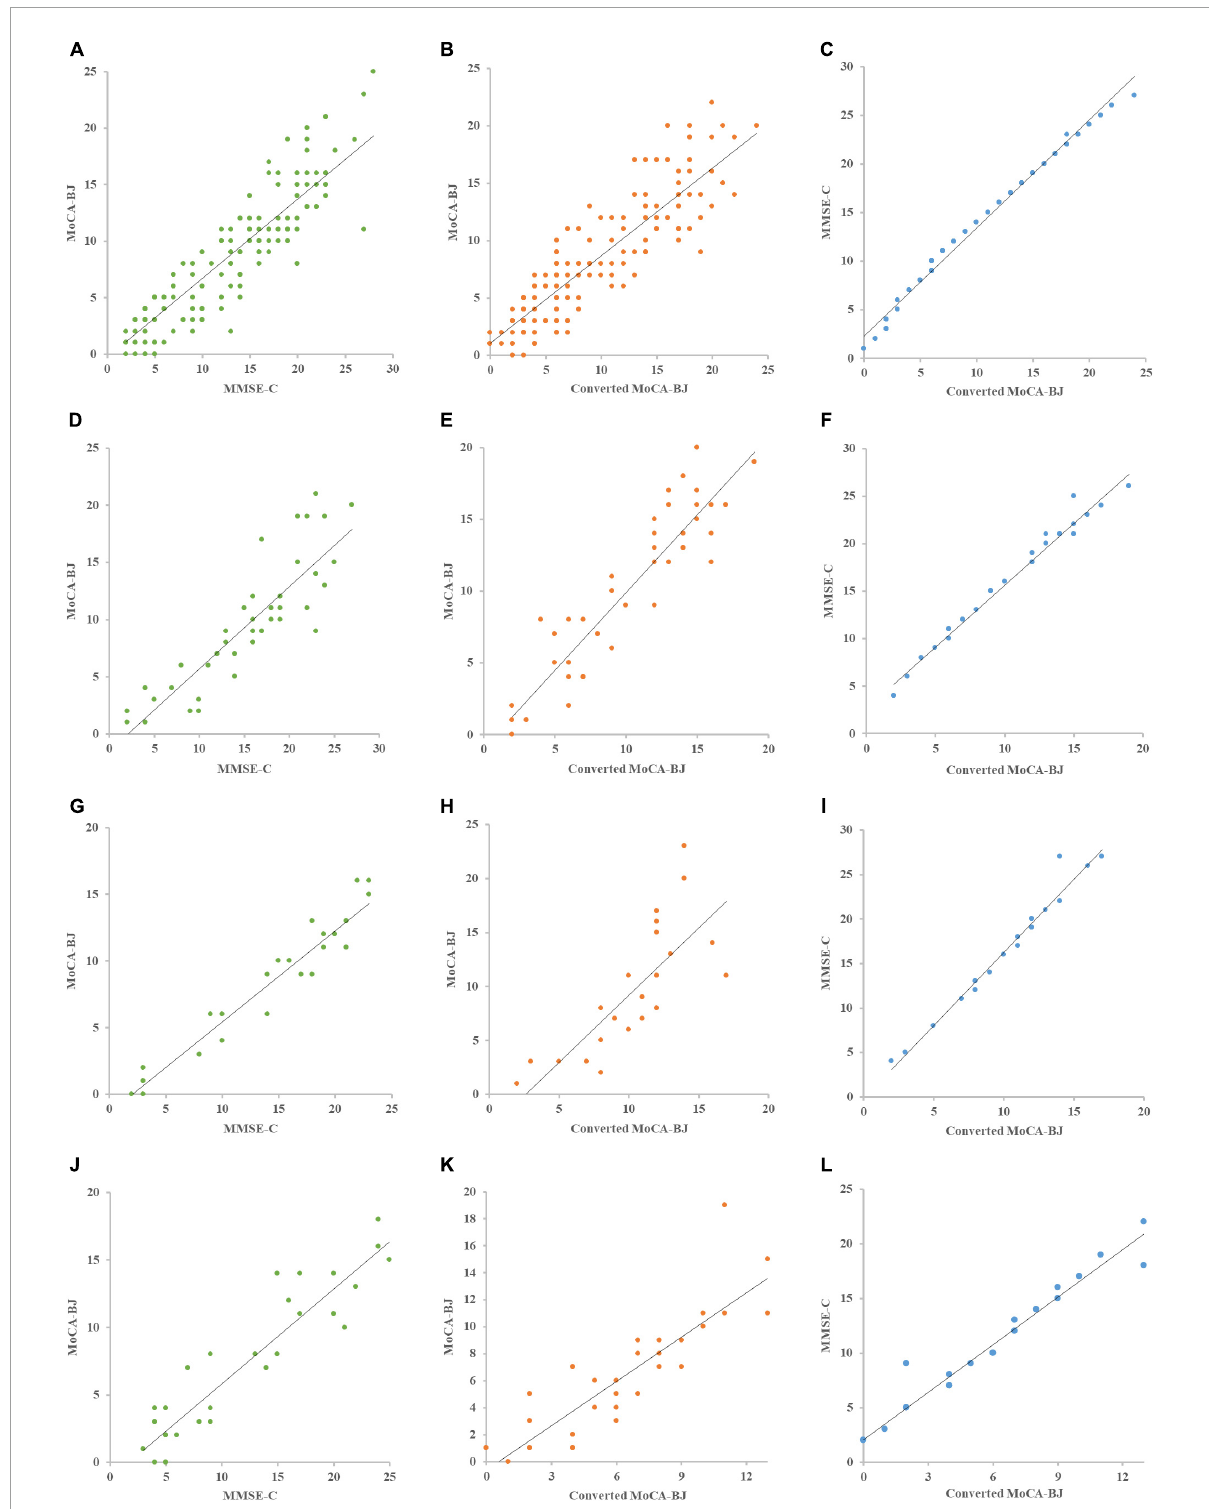
FIGURE2 Mini-mental state examination, montreal cognitive assessment, converted MoCA-BJ distribution scatter plot of groups. (A–C) The MMSE-C, MoCA-BJ, and converted MoCA-BJ distribution scatter plot of tatol group, (D–F) the MMSE-C, MoCA-BJ, and converted MoCA-BJ distribution scatter plot of high education subgroup, (G-I) the MMSE-C, MoCA-BJ, and converted MoCA-BJ distribution scatter plot of medium education subgroup, (J-L) the MMSE-C, MoCA-BJ, and converted MoCA-BJ distribution scatter plot of low education